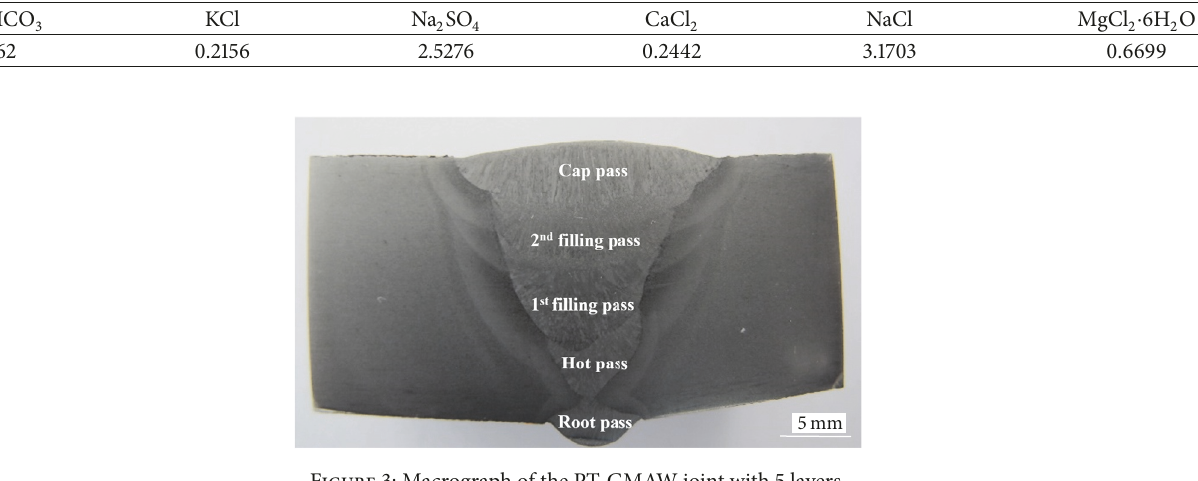
Figure 3: Macrograph of the PT-GMAW joint with 5 layers.